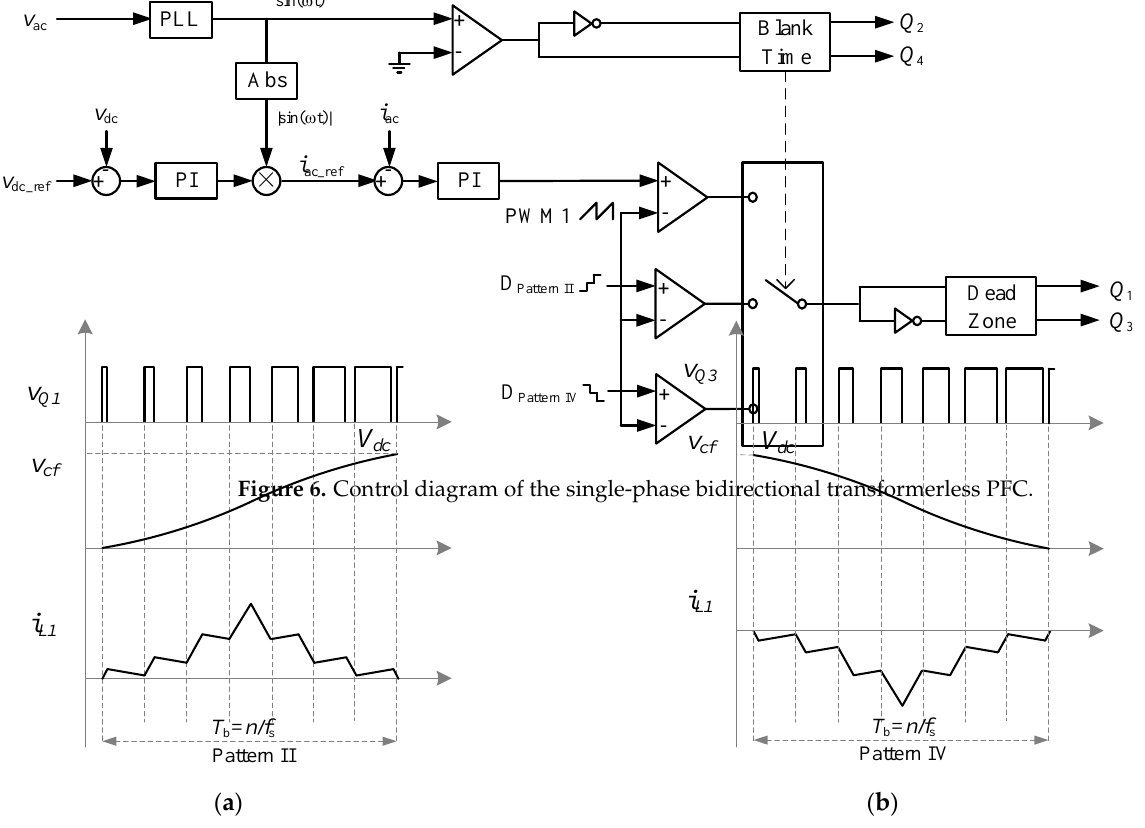
Figure 7. The zoomed-in waveform during the grid voltage zero-crossing. ( a ) Pattern II and ( b ) Pattern IV.